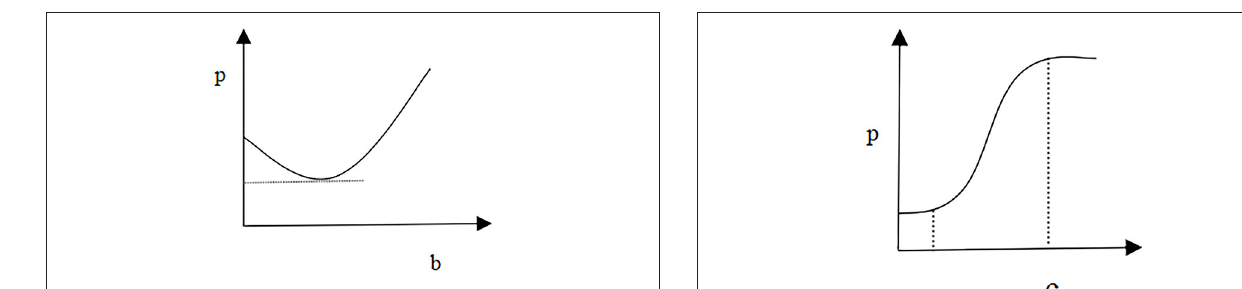
FIGURE 2 | Price and preference.